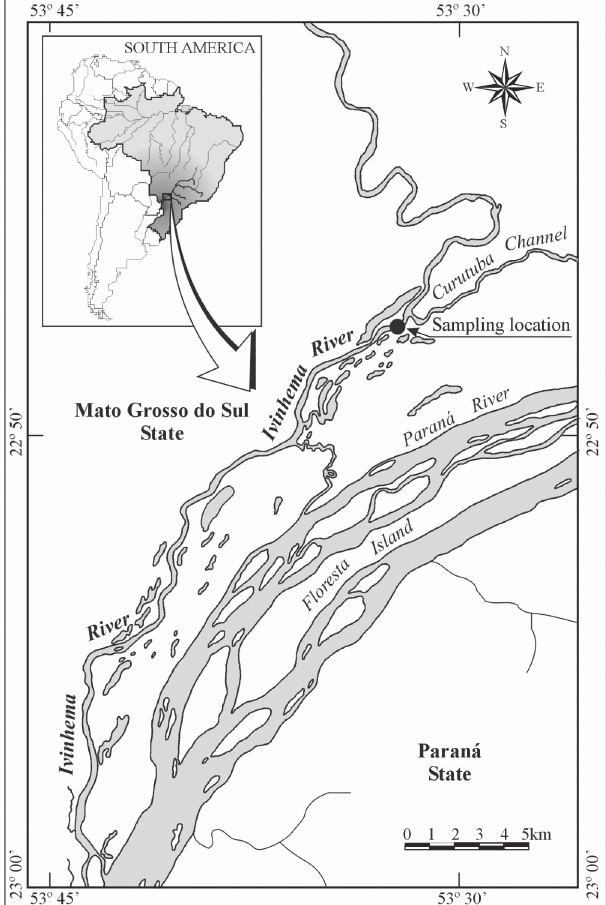
Fig. 1. Map of the floodplain section of the upper Paraná River included in this study, identifying the Ivinhema River and the approximate location where the drifting macrophyte mats were